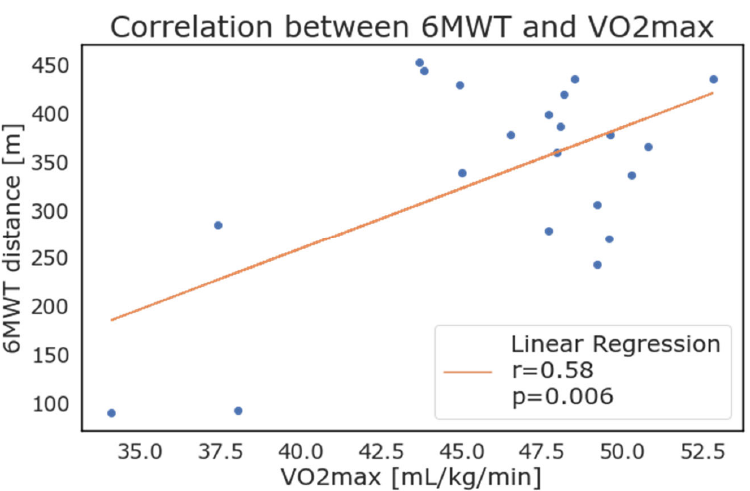
Figure 6. Correlation between 6 ‐ minute walking test results and maximal oxygen consumption (VO2max) as calculated and reported by wearable devices. (VO2max) as calculated and reported by wearable